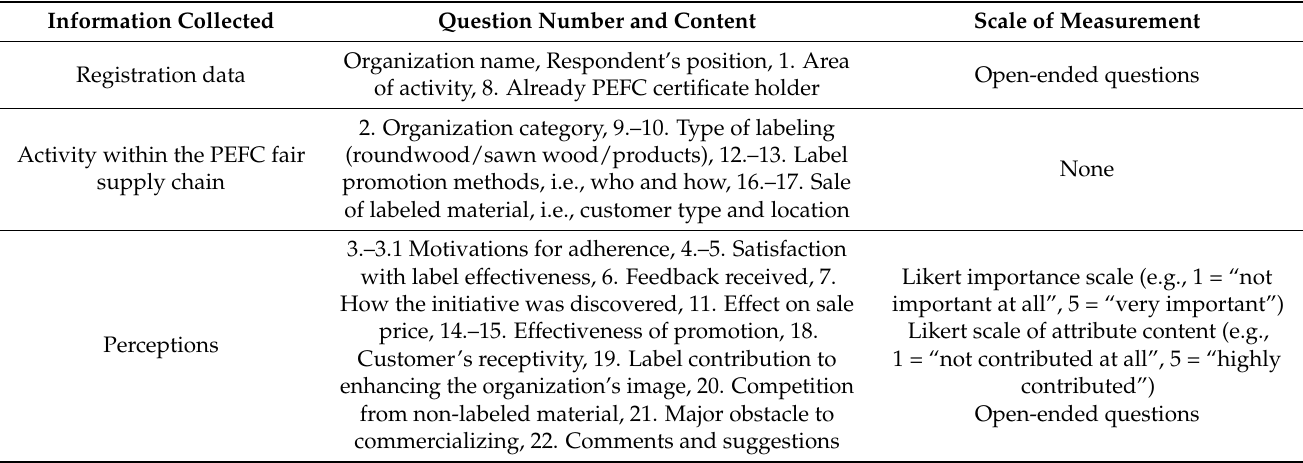
Table 1. Outline of the